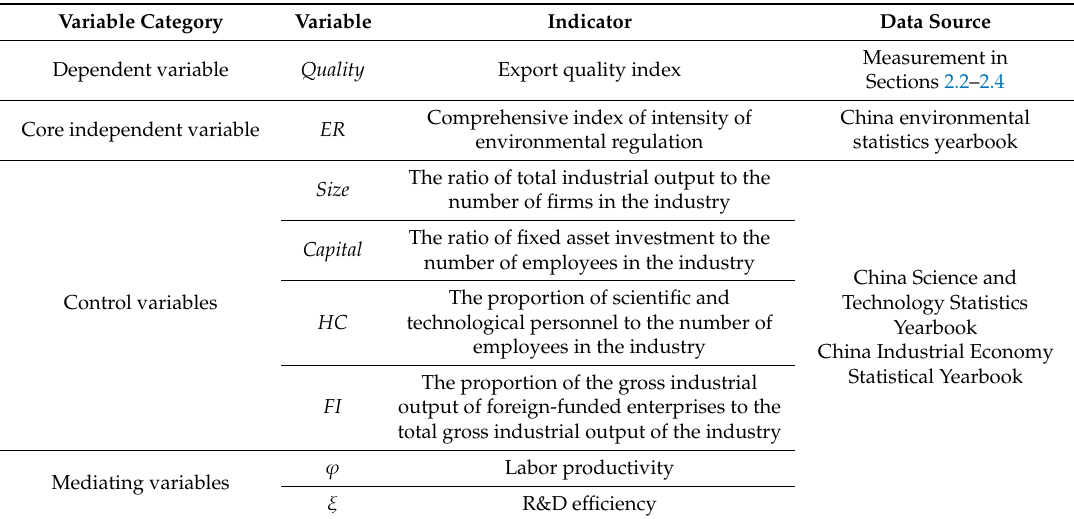
Table 4. Indicators and data sources for the main